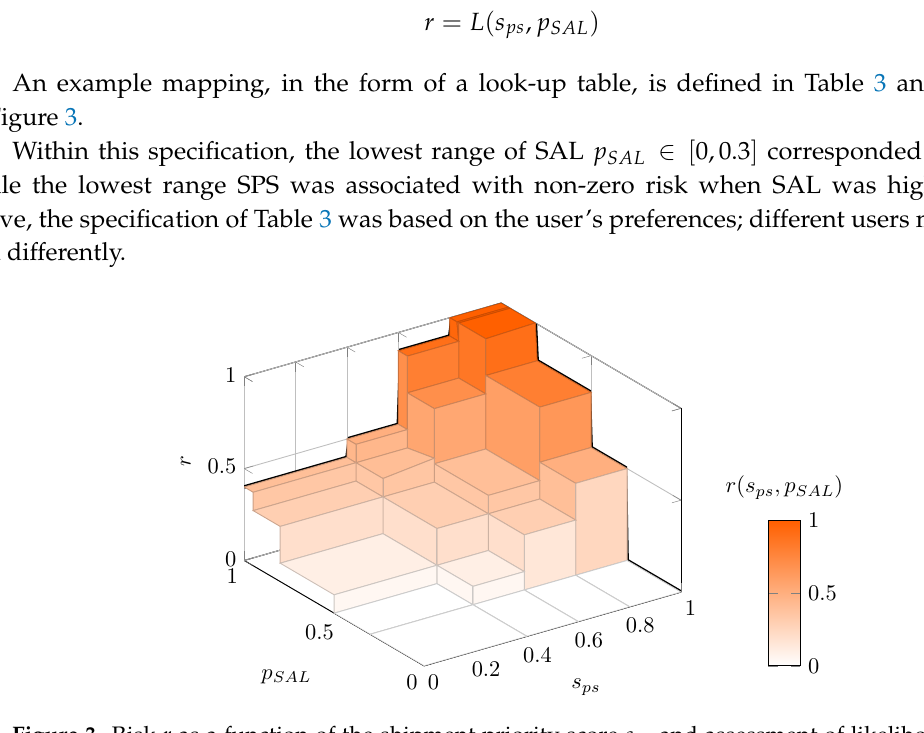
Figure 3. Risk r as a function of the shipment priority score s ps and assessment of likelihood p SAL , as defined in Table